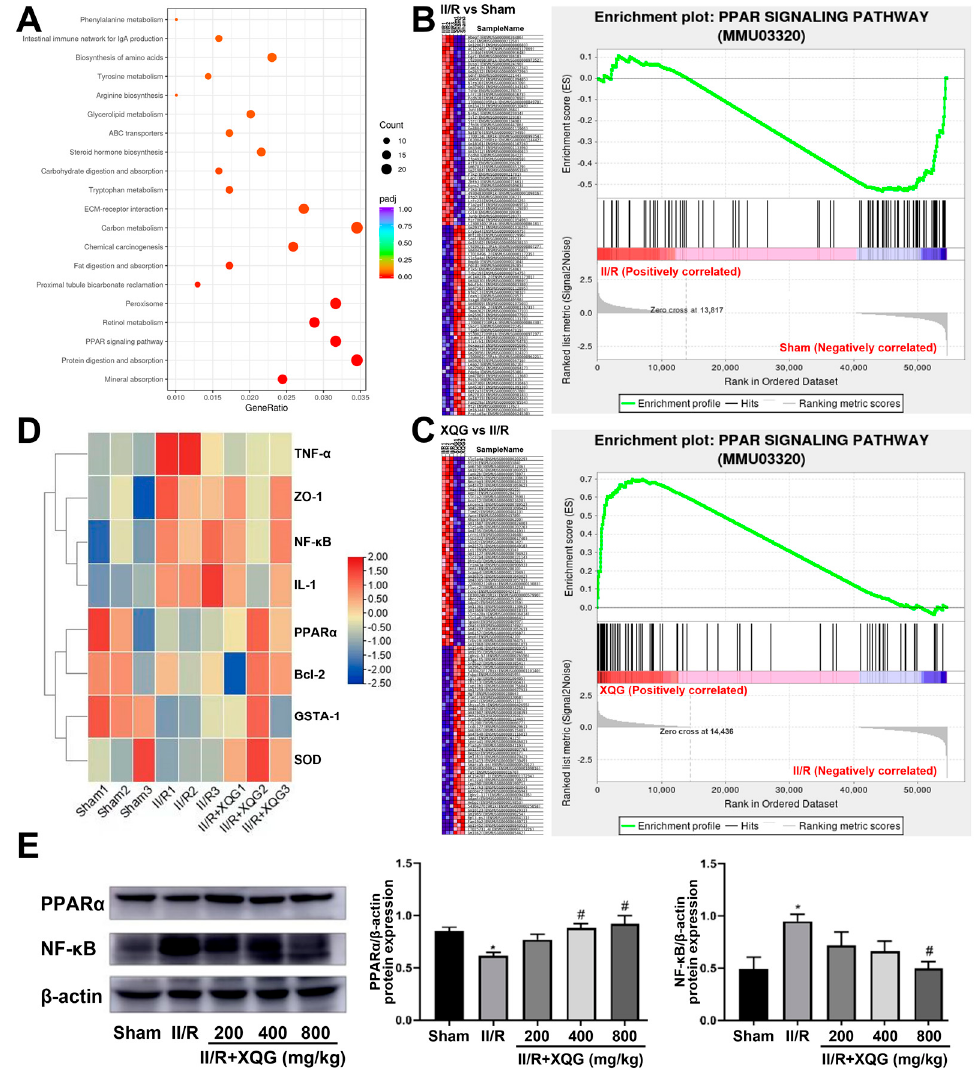
Figure 7. KEGG pathway enrichment. ( A ) KEGG enrichment result of DEGs after XQG administra- tion; ( B , C ) Enrichment plots of PPAR signaling pathway from GSEA analysis after II/R injury ( B ) and XQG administration ( C ); ( D ) Heat map of gene expression levels of PPAR α , NF- κ B, Bcl2, TNF- α , IL-1, Gsta1 and SOD; ( E ) The protein expression levels of PPAR α and NF- κ B in the intestinal tissue. All values were expressed as mean ± SEM ( n ≥ 3). * p < 0.05 vs. sham group, # p < 0.05 vs. II/R group.